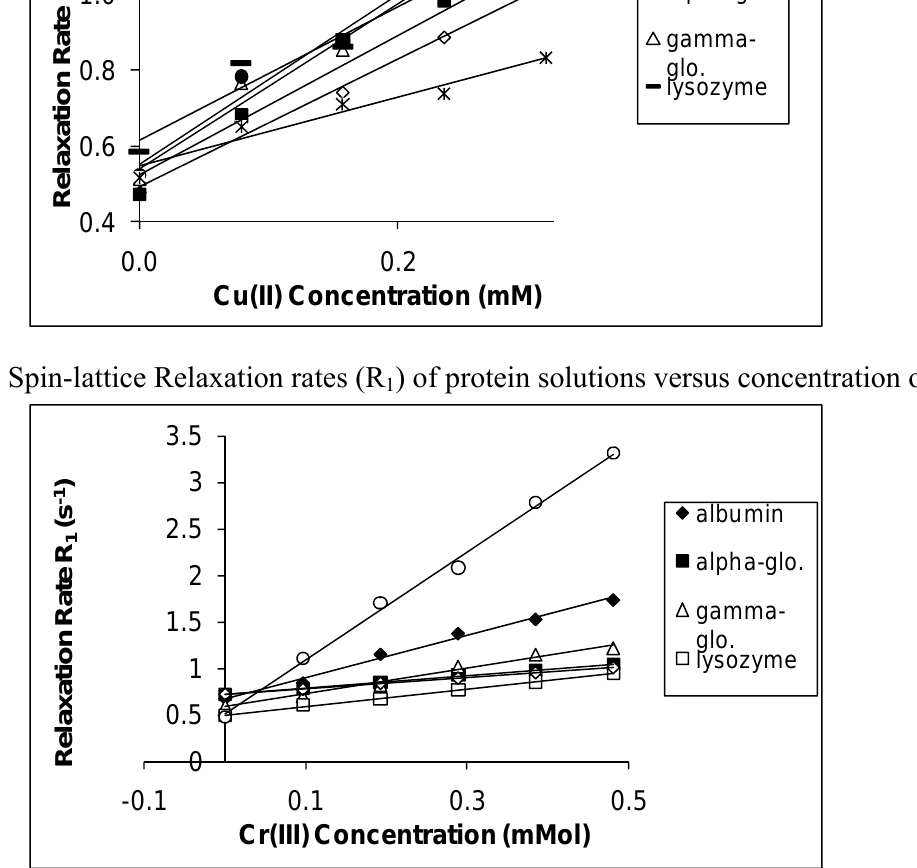
Figure 4. The Spin-Spin Relaxation rates (R